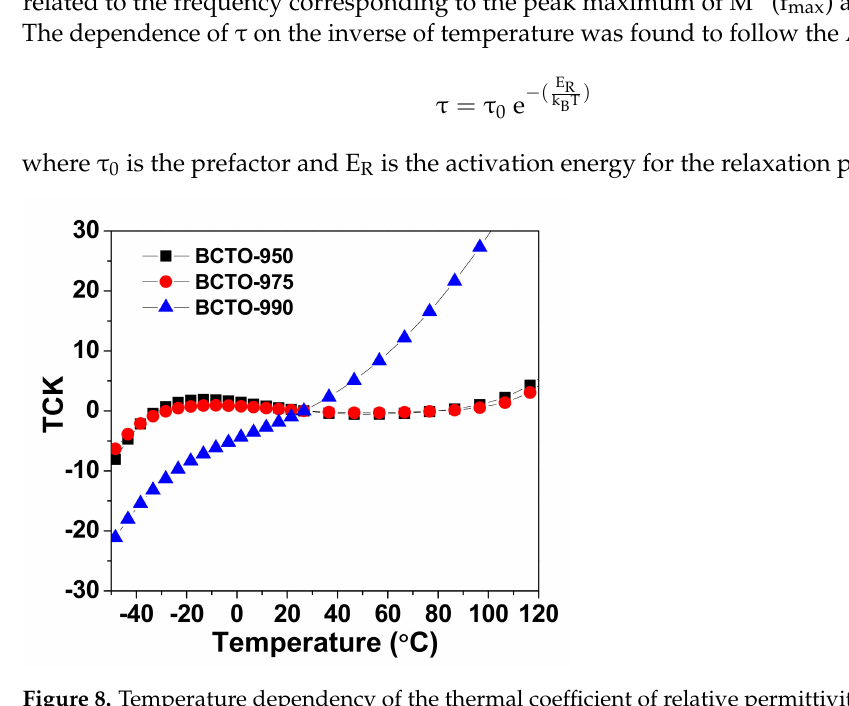
Figure 8. Temperature dependency of the thermal coefficient of relative permittivity (TCK) for the BCTO ceramics.